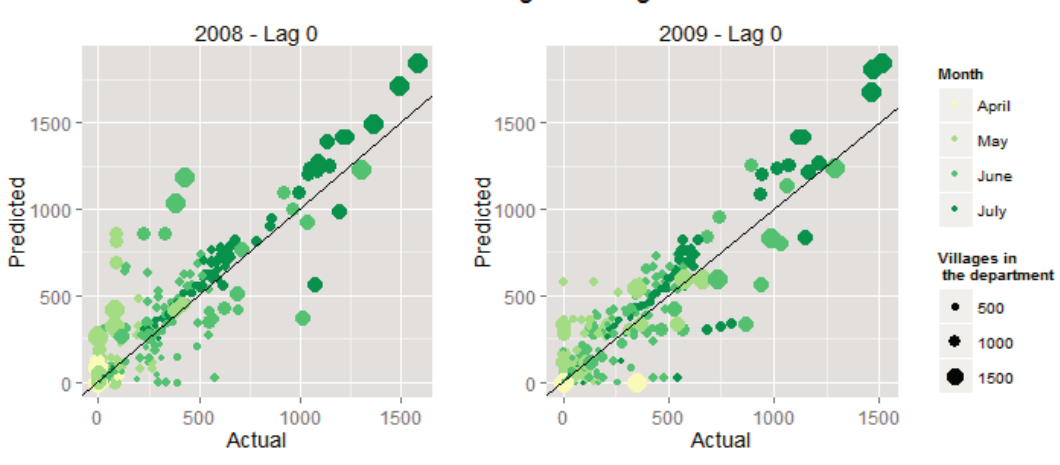
Figure 4. Actual versus predicted (Lag0 specification) number of villages having sown by department and by dekad. Points’ size are proportional to the total number of villages within a department and months are in shades of green. Number of observations: 34 departments multiplied by 12 periods equals 408 observations for each